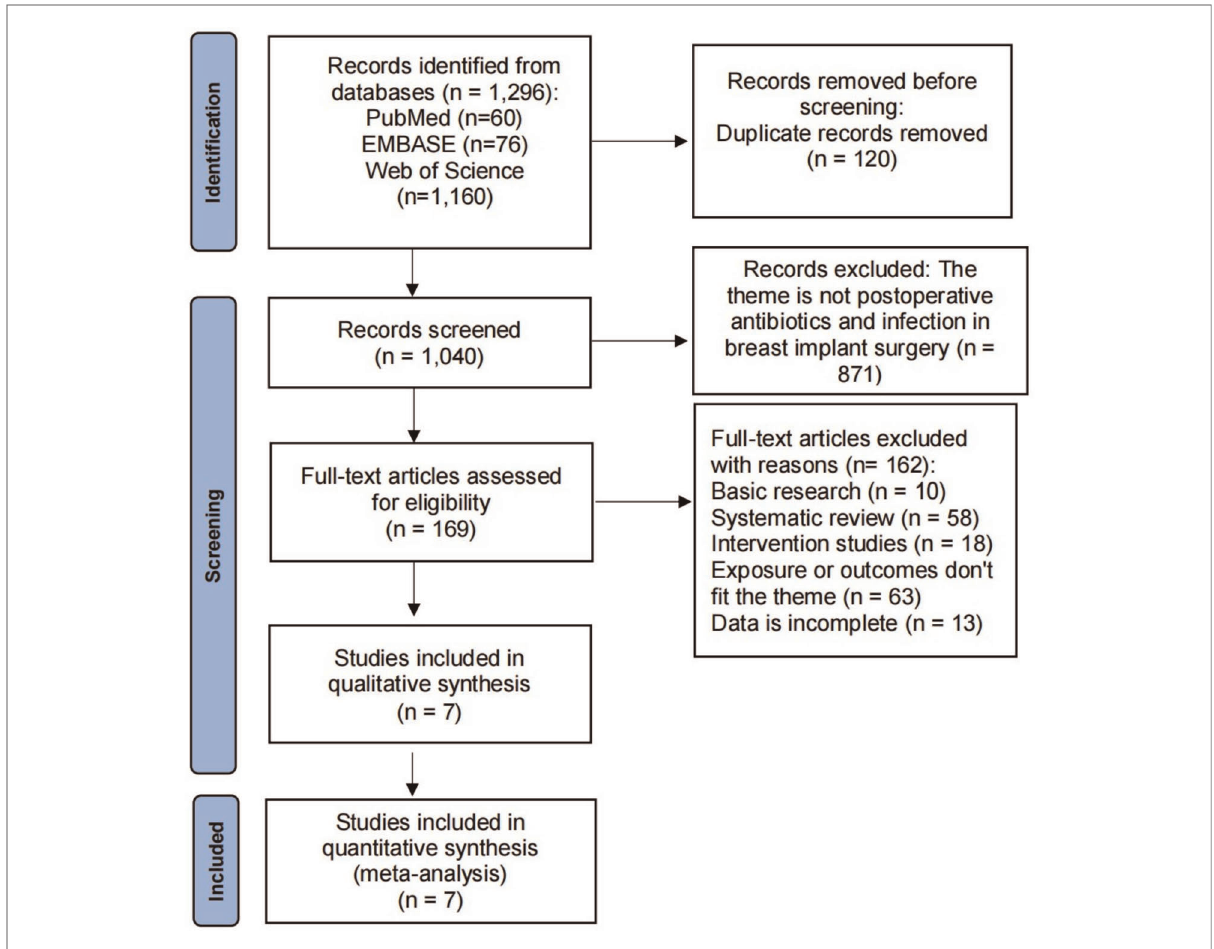
FIGURE 1 PRISMA fl ow